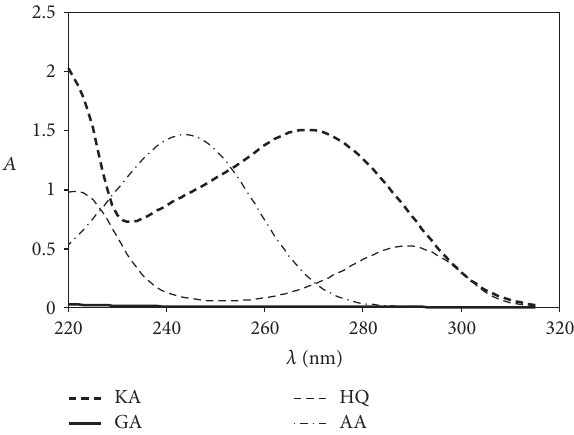
Figure 1: UV absorption spectra of HQ, KA, AA, and GA; every compound has the same concentration (2 × 10 −4 mol ⋅ L −1